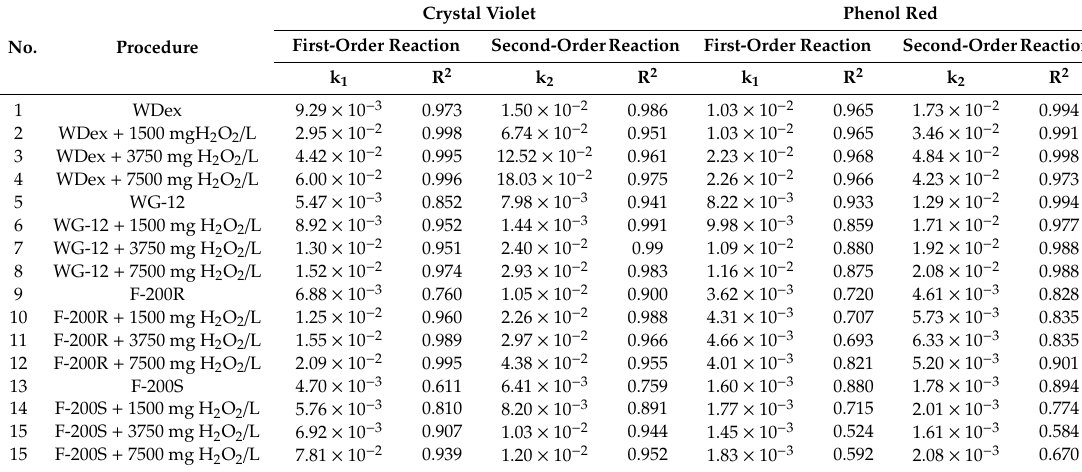
Table 2. Kinetic parameters of crystal violet and phenol red removal in the presence of hydrogen peroxide and activated